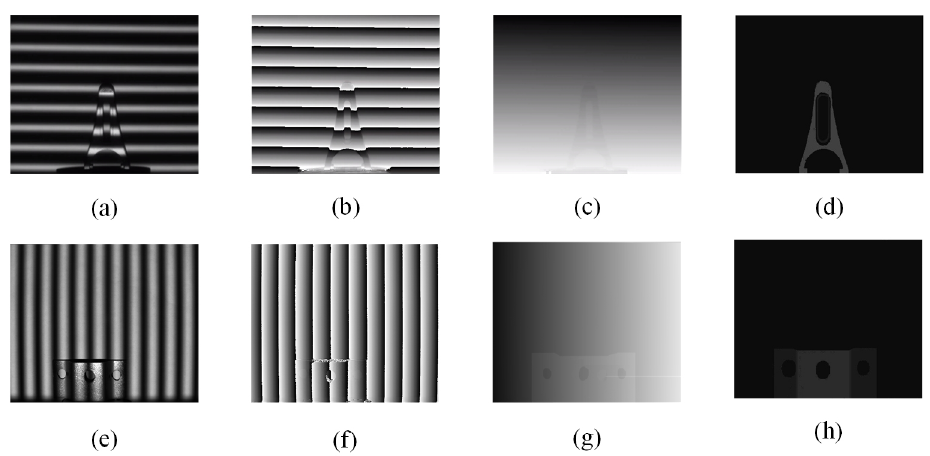
Figure 9. The two objects in the figure were projected by horizontal and vertical fringe. ( a , e ) were fringe images, ( b , f ) were wrap phase images, ( c , g ) were unwrap phase images, ( d , h ) were disparity images based on phase similarity.